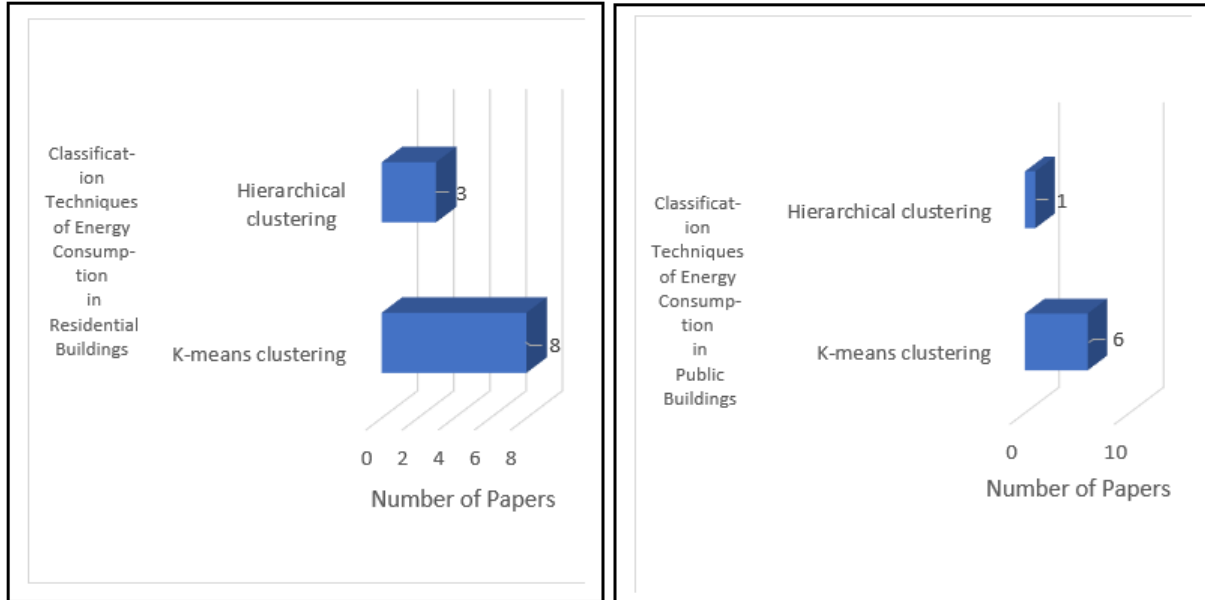
Figure 9. Classification techniques that used energy consumption in residential and public buildings.